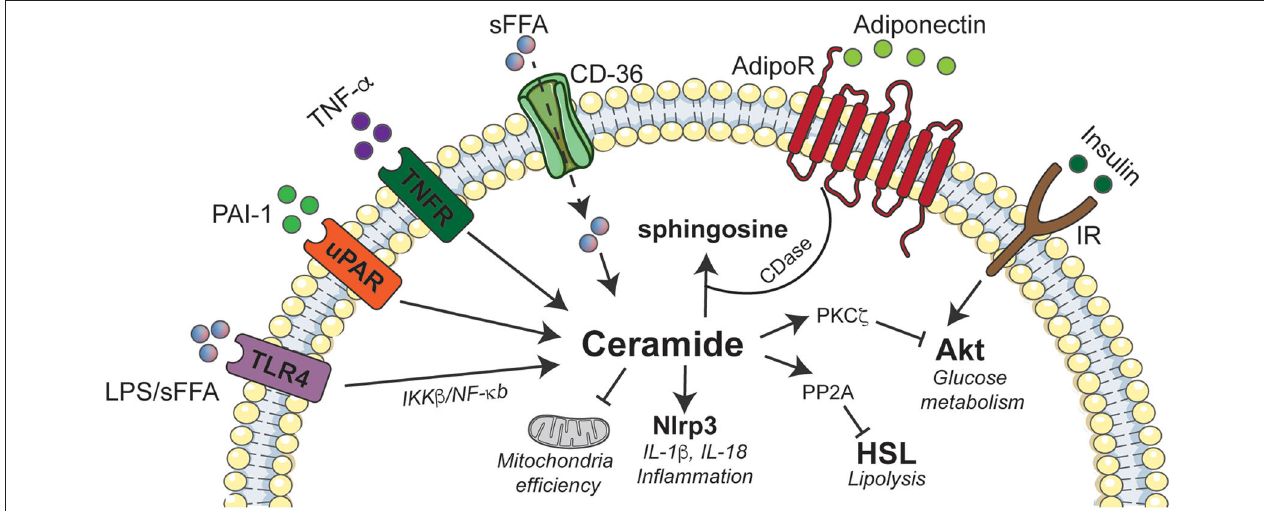
FIGURE 2 | Schematic depicting interactions between ceramides and inflammatory agonists in adipose tissue. Ceramide accumulation elicits deleterious effects on adipose tissue function by activating Nlrp3 inflammasome that induces inflammation, inhibition of Akt via PKC ζ to abrogate insulin signaling, and promoting excessive lipid storage by inhibiting HSL. The immunomodulatory adiponectin exhibits some of its beneficial effects by stimulating ceramidase activity that converts ceramides to sphingosine. Akt, Protein Kinase B; CD-36, cluster of differentiation 36; AdipoR, Adiponectin receptor; CDase, Ceramidase; IKK, Ikappa kinase; IL, interleukin; IR, insulin receptor; LPS, lipopolysaccharide; NF- κ B, Nuclear factor kappa-light-chain-enhancer of activated B cells; Nlrp3, NLR family, pyrin domain containing 3; PAI-1, Plasminogen activator inhibitor 1; PKC, protein kinase C; PP2A, Protein phosphatase 2A; sFFA, Saturated fatty acids; TLR4, Toll like receptor-4; TNF- α ,